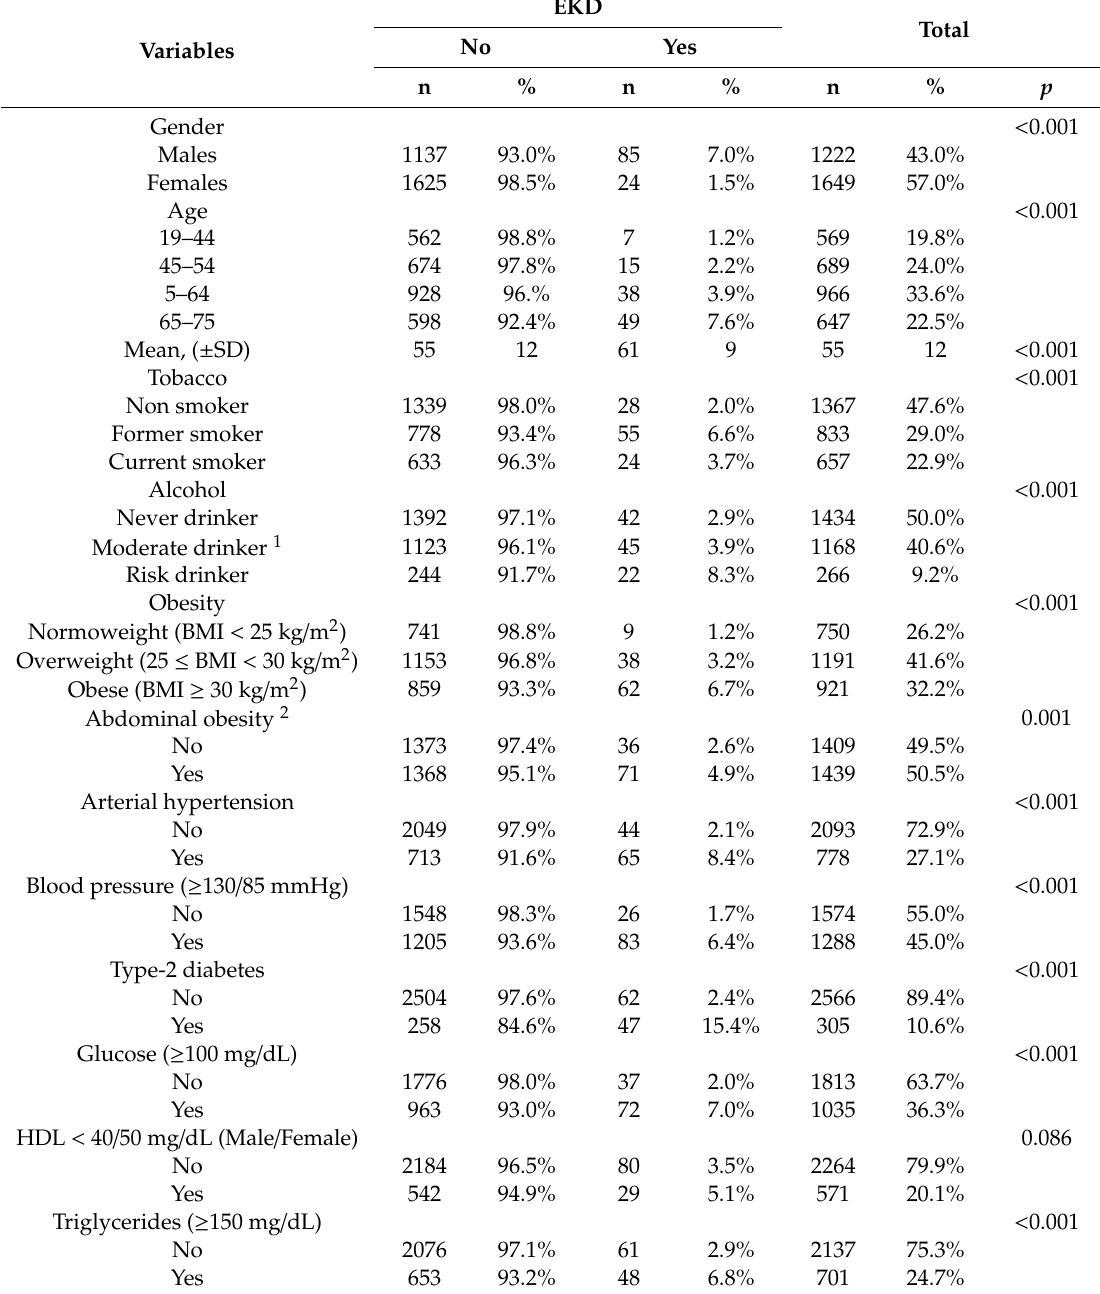
Table 1. Baseline characteristics of the 2871 subjects included in the study and associated factors according to the presence of early kidney disease